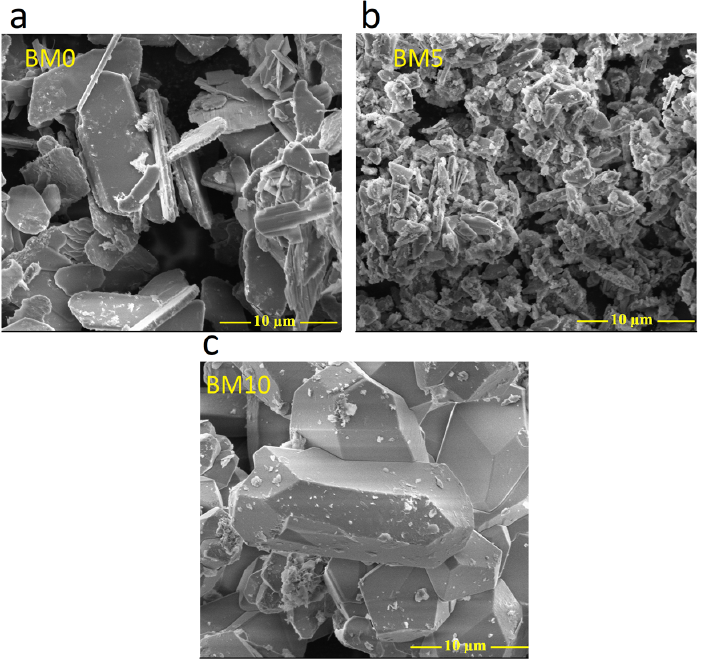
Minerals 2021 , 11 , x FOR PEER REVIEW